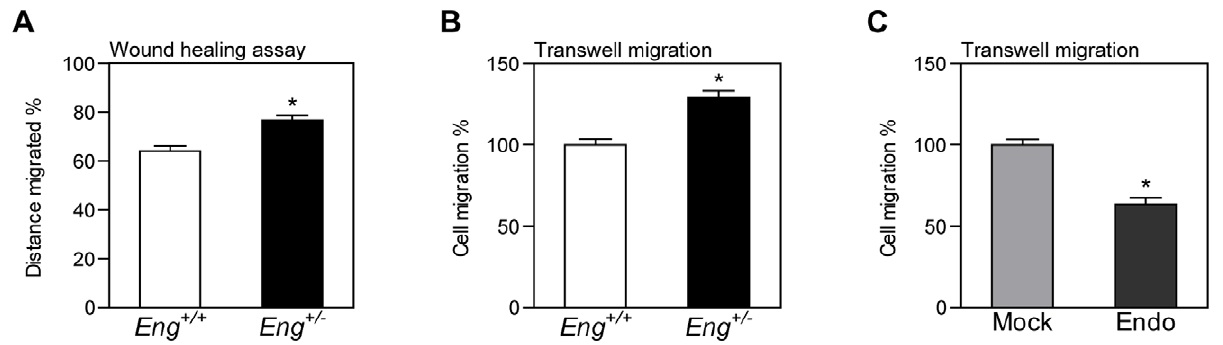
Figure 5. Effect of endoglin expression on fibroblast migration. ( A and B ) Eng + / + and Eng + / 2 MDF in vitro migration was analyzed by wound healing assay ( A ) and 8-mm pore transwell migration ( B ). ( C ) Migration of NIH3T3 fibroblasts overexpressing human endoglin (Endo) and infected with empty vector (Mock) was assessed by transwell assay. * p , 0.05-significance of the difference between cells, Student’s t -test.